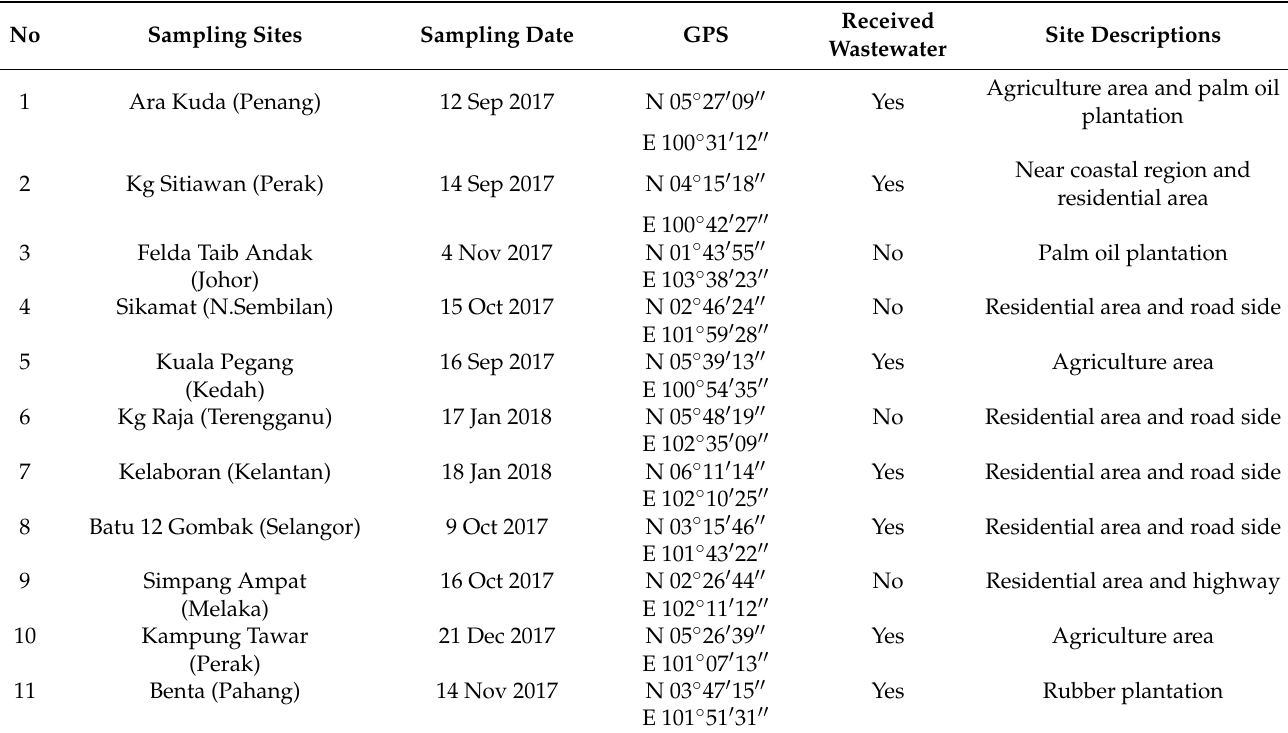
Table 1. Information on the sampling sites of Amaranthus viridis , and their habitat topsoils from Peninsular